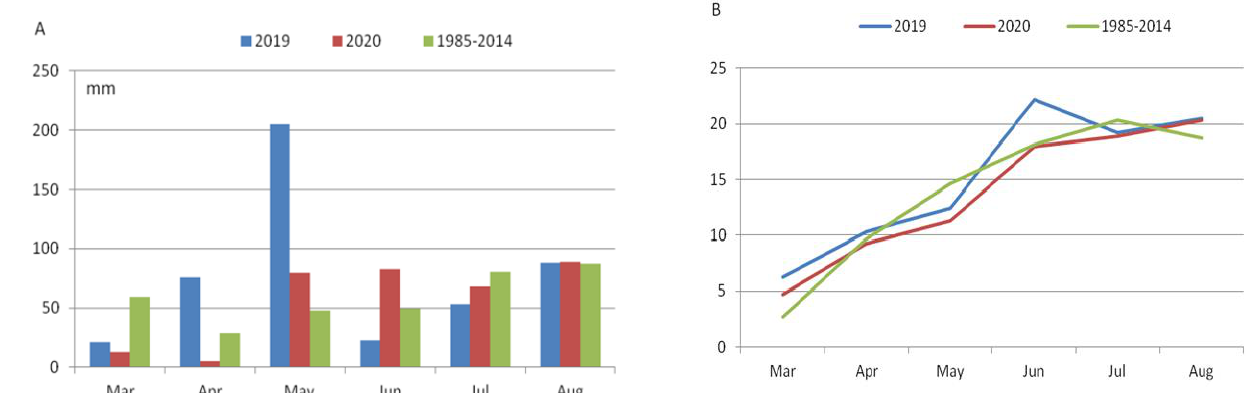
Figure 1. Average sum of precipitation ( A ) and temperature ( B ) in 2019 and 2020 and the long-term average from 1985–2014 (according to the Meteorological Station in Balice).